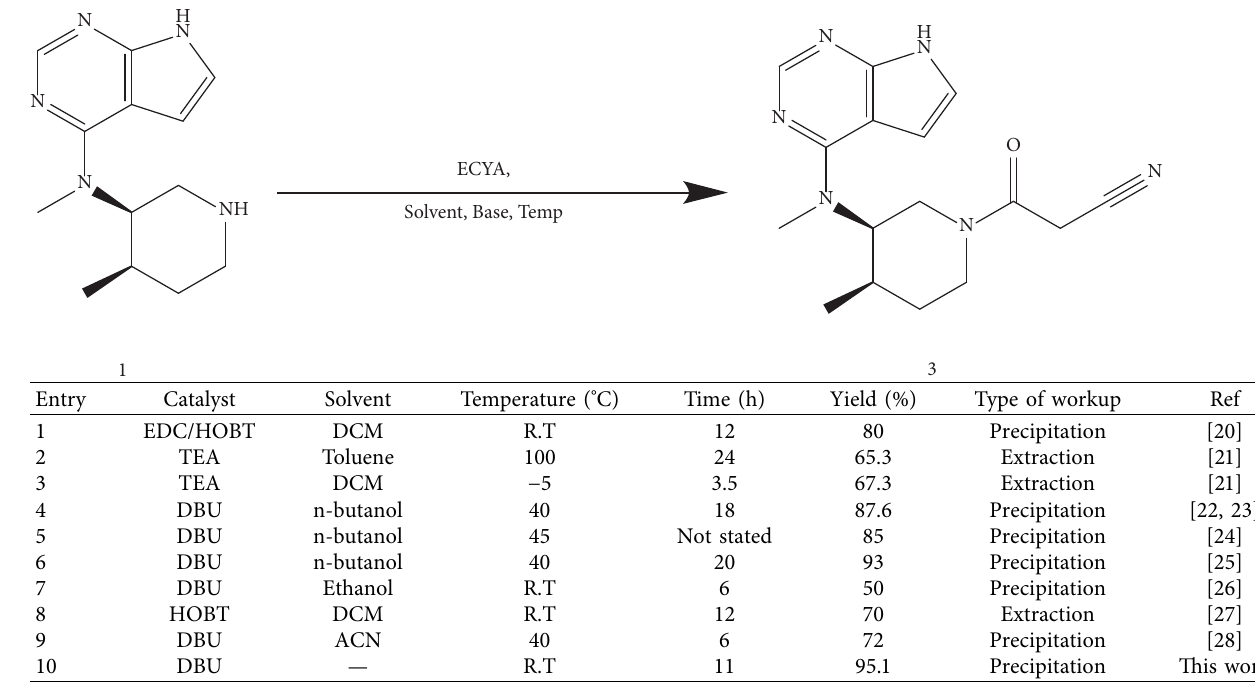
Table 1: A comparison between the examples of the previous reports and the present